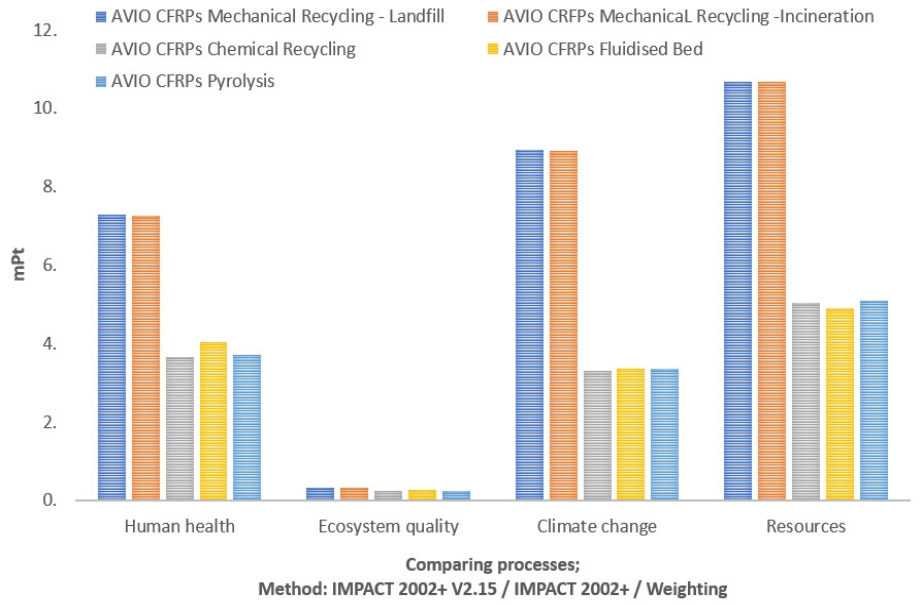
Figure 24. Results of comparison of recycling routes with CF recovery into endpoint categories.